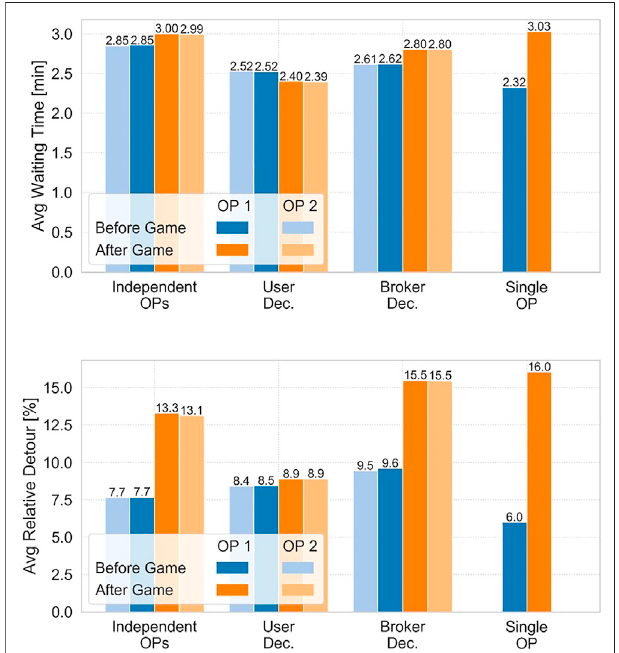
FIGURE 11 | Customer waiting time (top) and relative detour time (bottom) before and after the game for the different interaction scenarios.